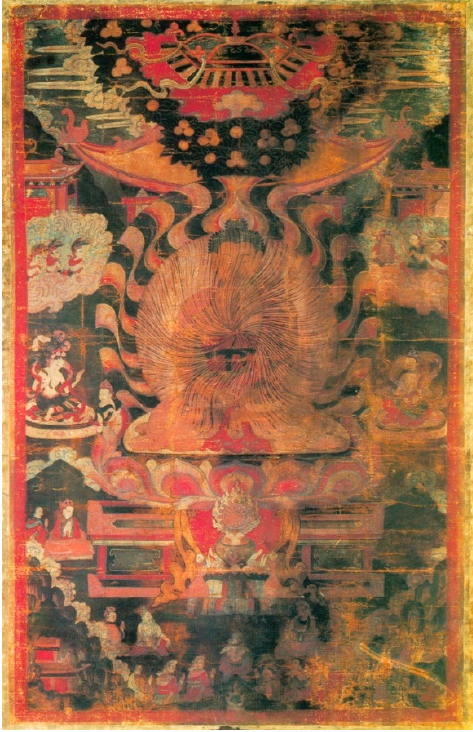
Figure 8. Private collection: item number 31838, Himalayan Art Resources, public domain work.